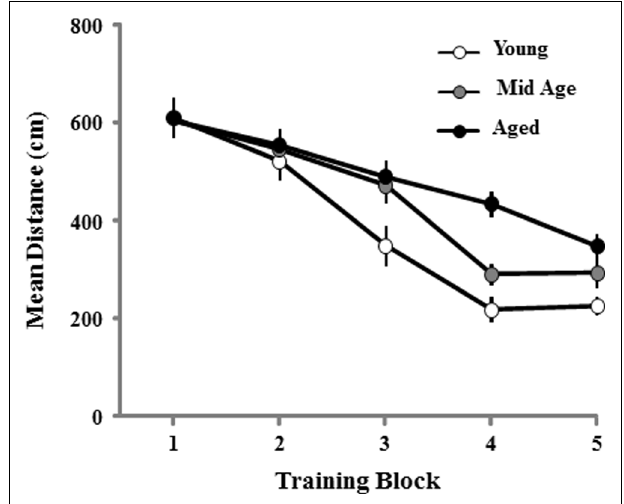
FIGURE 2 | Mean path length to find the escape platform during the cue discrimination task in the water maze. Data represents the mean distance traveled ( ± SEM) per training block in the cue discrimination task for young (open circle, n = 36), middle-age (Mid Age, gray circle, n = 44), and aged (filled circle, n = 44)